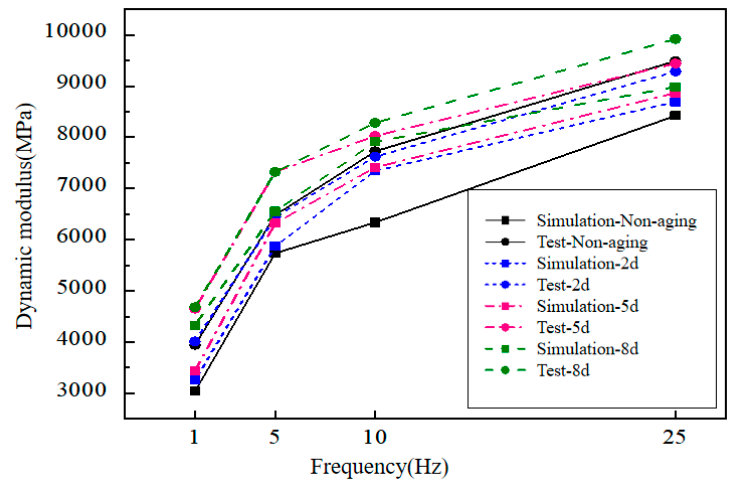
Figure 17. Comparison of dynamic modulus simulation results and actual test results under different frequencies and aging conditions.